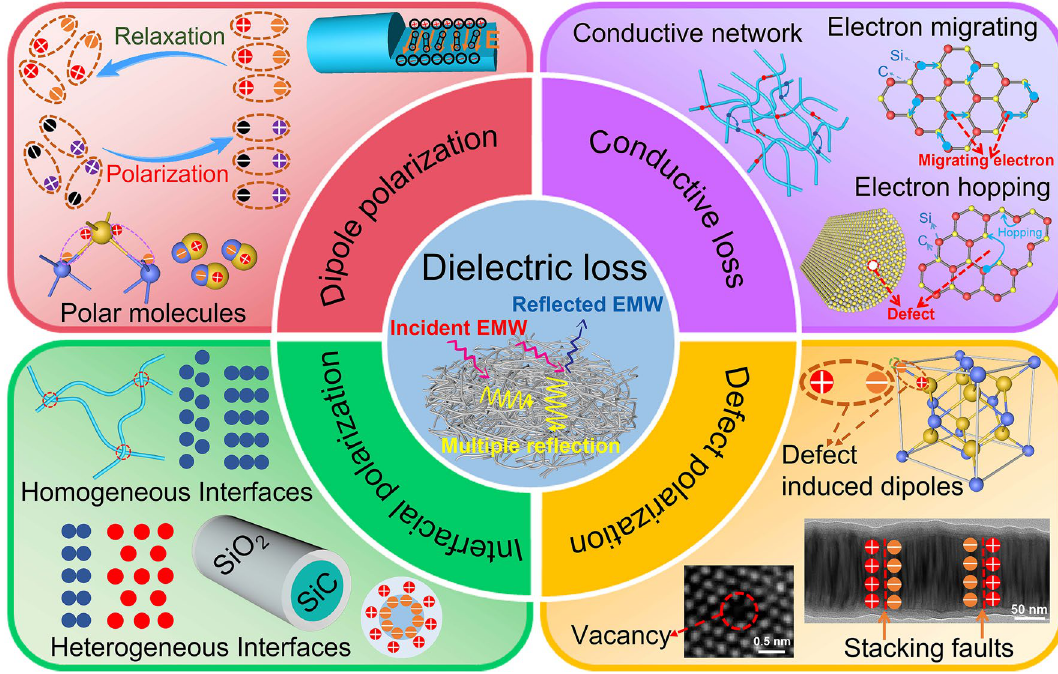
Fig. 10 Schematic of the EMW absorption mechanisms for the SiC@SiO 2